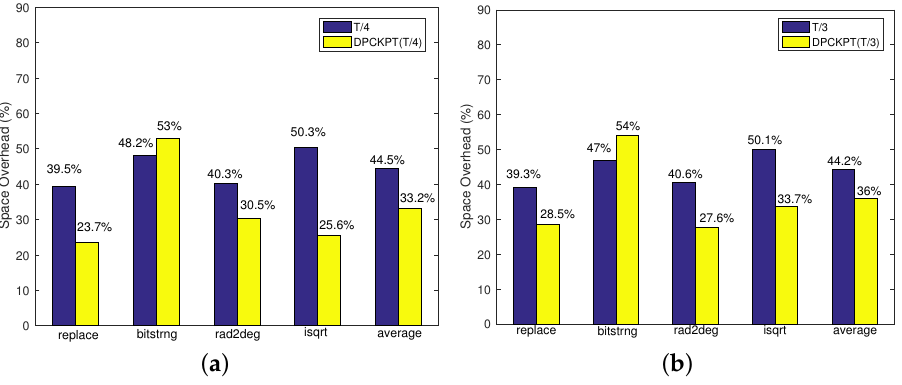
Figure 14. ( a ) The result of the space overhead of the periodic checkpointing recovery approach with a checkpoint interval of T/4 and that of DLCKPT that redeploys the checkpoints of checkpoint interval of T/4. ( b ) The result of the space overhead of the periodic checkpointing recovery approach with a checkpoint interval of T/3 and that of DLCKPT that redeploys the checkpoints of checkpoint interval of